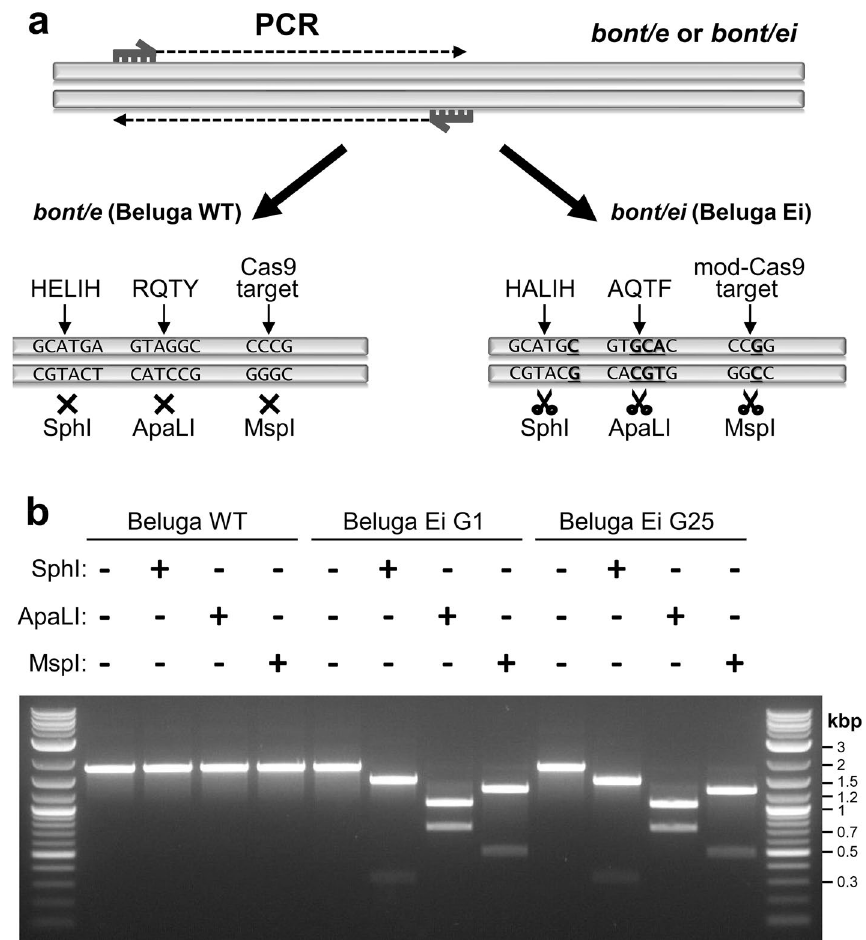
Figure 3. Restriction digestion-based verification of the presence of designed nucleotide modifications within bont locus of Clostridium botulinum Beluga wild-type (Beluga WT), Beluga Ei 1 st generation (Beluga Ei G1) and Beluga Ei 25th generation (Beluga Ei G25). ( a ) Schematic representation of the restriction digestion-based Beluga Ei strain validation. Altered nucleotides introducing the restriction sites are underlined. ( b ) Agarose gel electrophoresis visualizing the PCR amplicons after restriction digestion. Full-length agarose gel is presented in Supplementary Figure